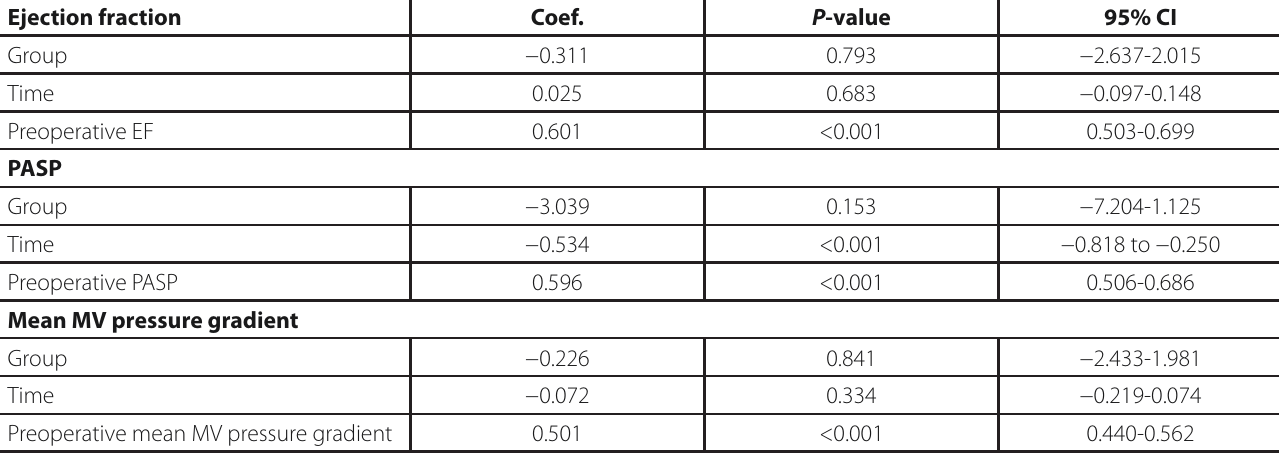
Table 5. Mixed-effects REML regression for the changes in left ventricular ejection fraction, pulmonary artery systolic pressure, and mean mitral valve pressure